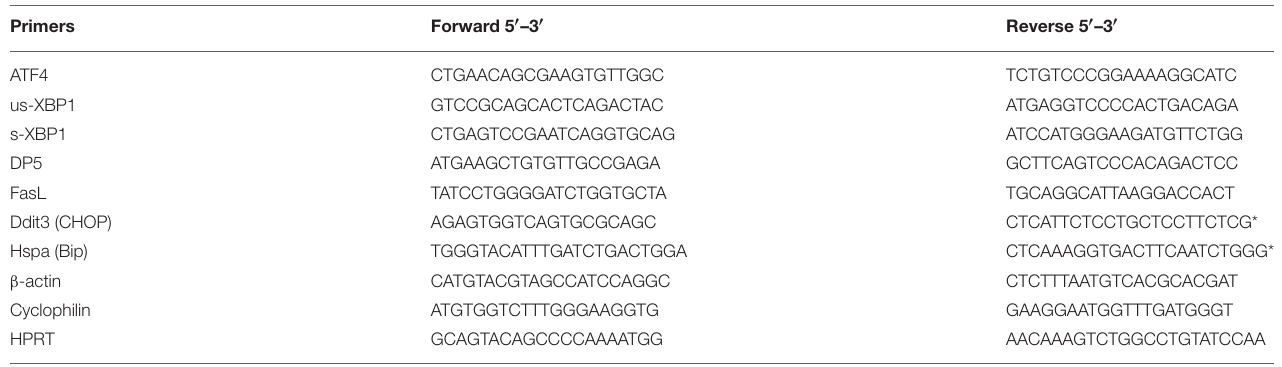
TABLE 2 | Primer sequences used for